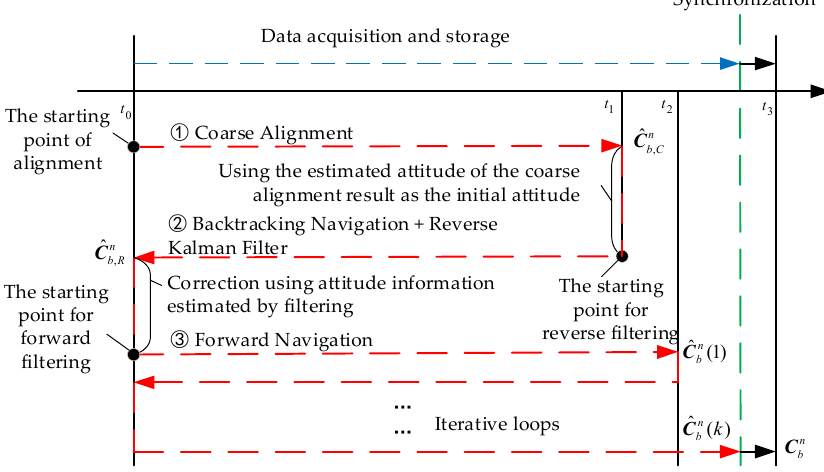
Figure 3. The self-alignment strategy of LV launched on the offshore